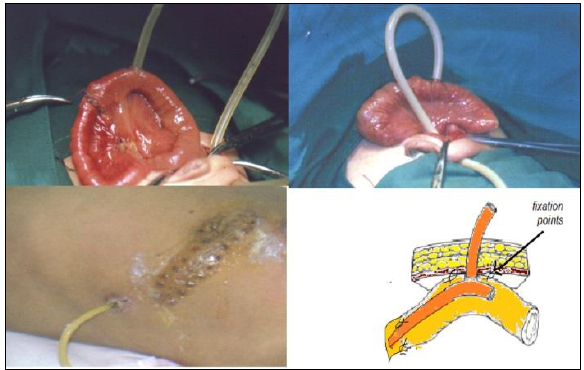
Figure 3: Steps of T-tube enterostomy